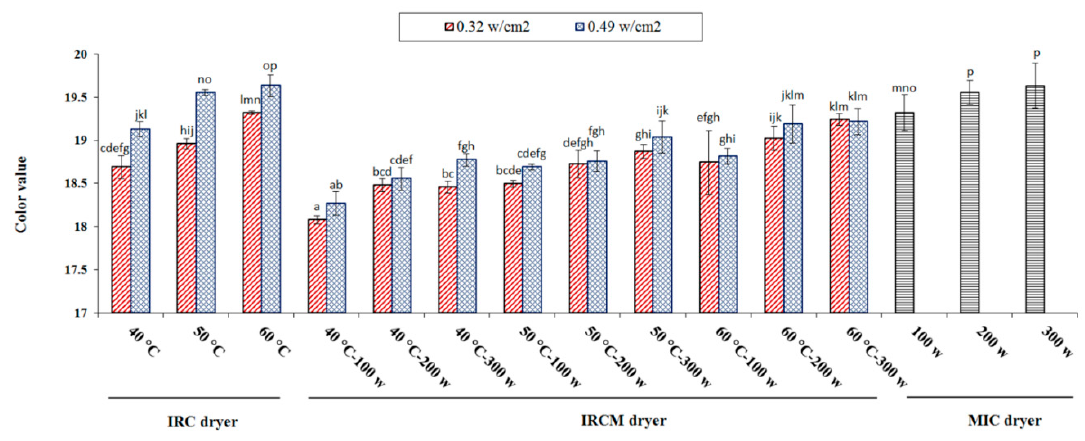
Figure 5. The color value affected by different drying methods for parboiled rice drying. Note: The same letter over column shows that the mean amount had no significant difference ( p < 0.05) based on Duncan’s test. The error bars represent standard error of the means.